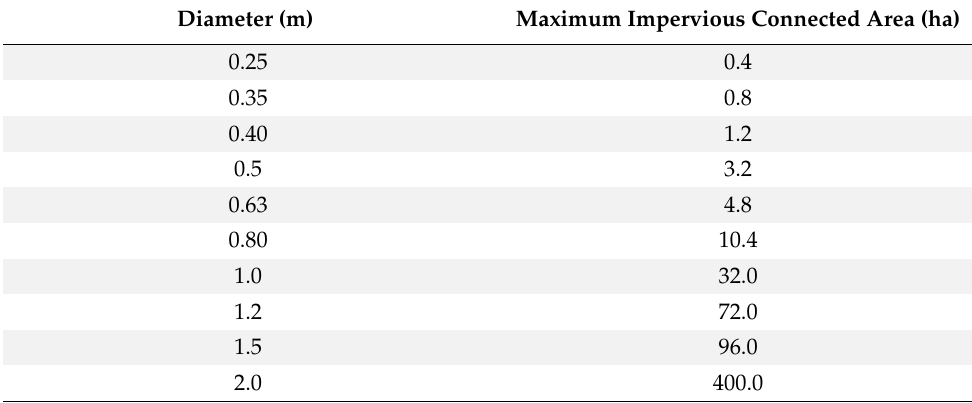
Table 3. Commercial sewer diameter and corresponding maximum impervious contributing area for Area Diameter Index ( ADI